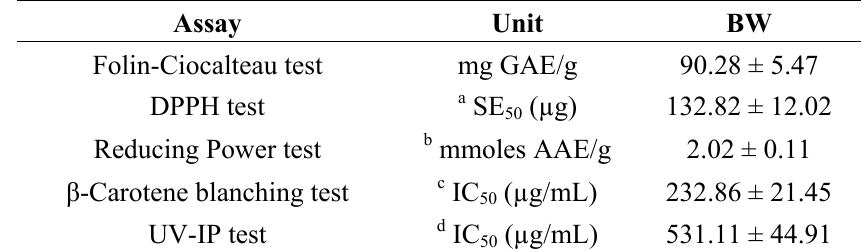
Table 3. Antioxidant activity of the blanch water (BW) extract measured by means of different in vitro tests. Data are expressed as mean±SD of three independent